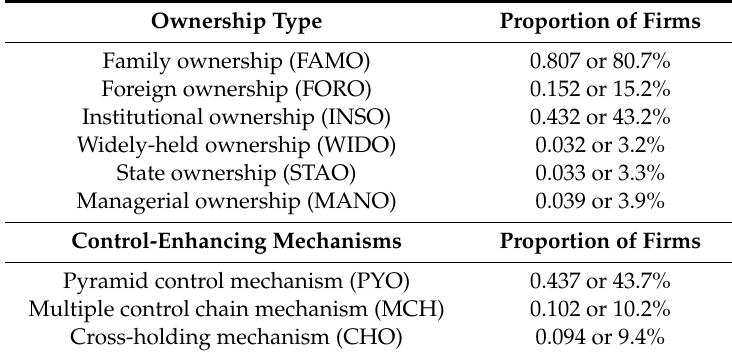
Table 4. Ownership and control-enhancing mechanism proportions in